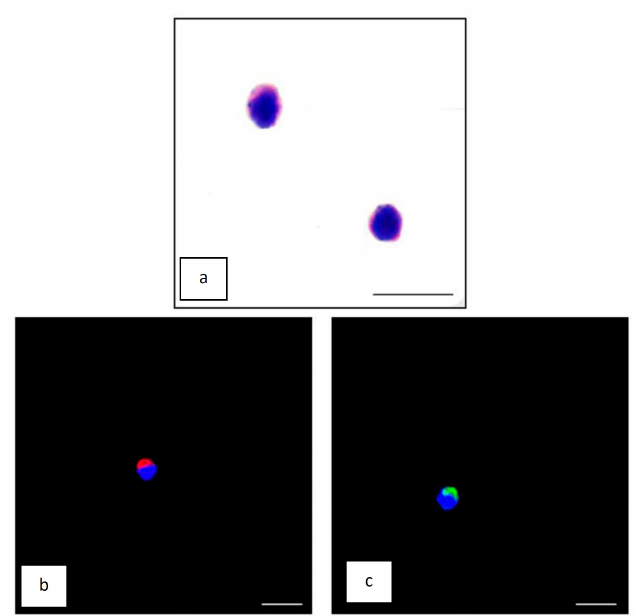
Figure 5. May Grünwald-Giemsa-stained lymphocyte of a control subject ( a ); and a confocal image showing inducible Nitric Oxide Synthase (iNOS) positivity ( b ); and cytochrome C positivity ( c ) lymphocytes of a placebo treated critically-ill patient. Scale bar = 20 μ m.